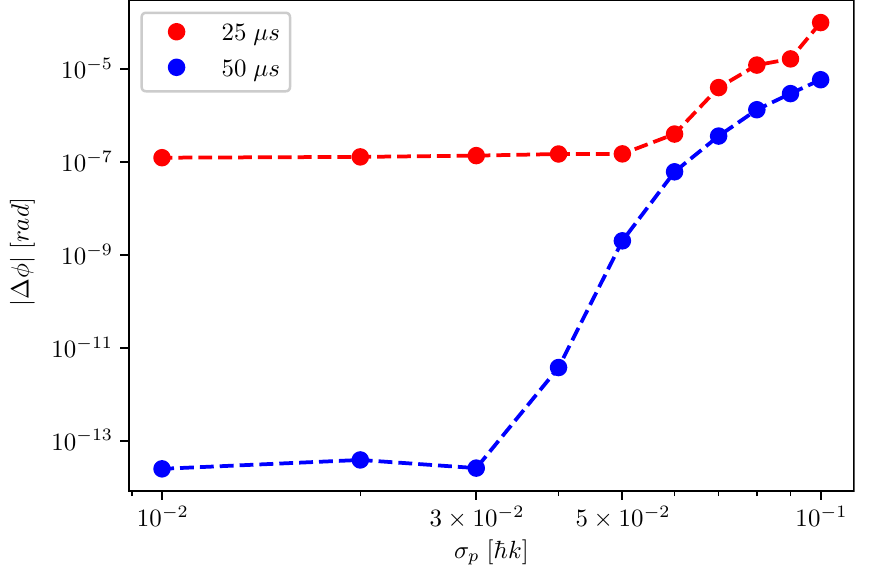
Figure 7. Phase shift of a 2 (cid:31) k Mach–Zehnder interferometer as a function of the initial momentum width of an 50 µ s (blue dots) and for 25 µ s and τ atomic sample. We evaluate the phase shift for pulse lengths of τ bs m = = 100 µ s (red dots), using peak Rabi frequencies of (cid:31) 25 µ s 1.06 ω 0.53 ω 50 µ s and τ τ bs m = r and (cid:31) 50 µ s = r . = = The dashed lines are a guide to the eye. We find a systematic decreasing behaviour of the relative phase 0.1 (cid:31) k (far right) to σ 0.05 (cid:31) k (red dots) and �φ offset starting from an initial momentum width of σ p p = = | | 0.03 (cid:31) k (blue dots). Reaching those critical initial momentum widths both curves show fixed relative σ p = 0.53 ω �φ phase offsets , which in the case of the interferometer with smaller Rabi frequency of � r (red = | | 14 rad (see text). The numerical simulations were performed with 65,536 10 dots) reaches a value of 2.5 − × 1 µ s and a free evolution time step of dt 10 µ s, leading grid points, an interaction time step of dt int free = = 12.69 s on four cores of an Intel Xeon X5670 processor with 2.93 GHz to a computational time of τ CPUtime = frequency and 12 MB of